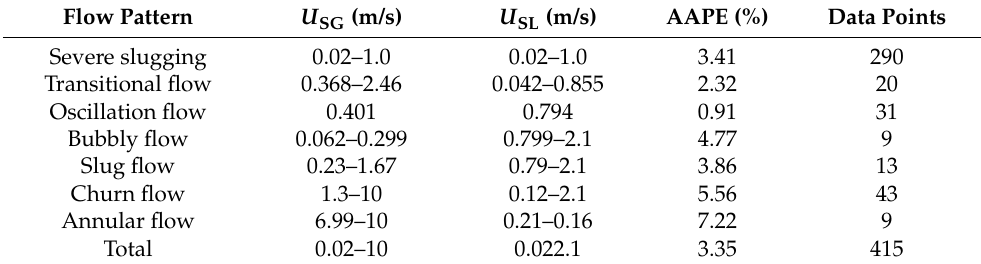
Table 4. Performance evaluation of the ANN model prediction against different flow